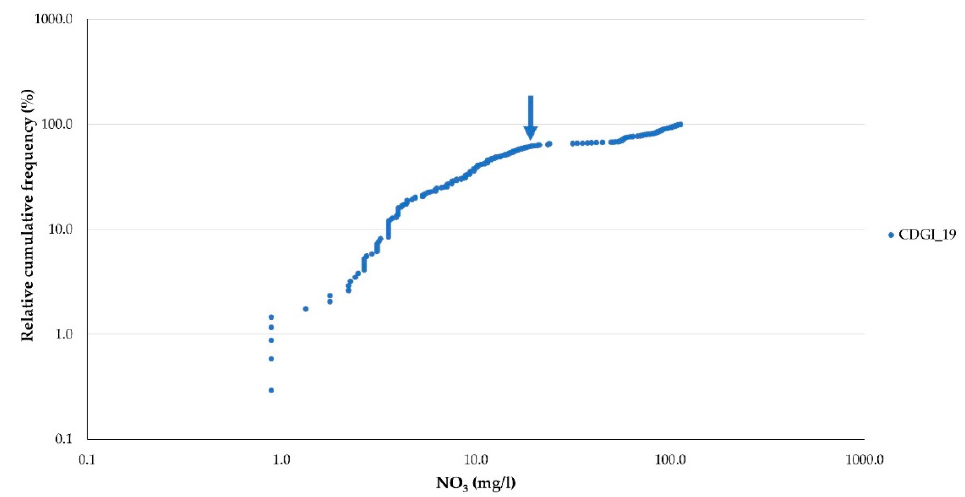
Figure 13. Cumulative relative frequencies of nitrate (NO 3 ) for the groundwater body CDGI_19. Arrow indicates value x considered for the calculation of Mean + 2SD and Median + 2MAD ranges.